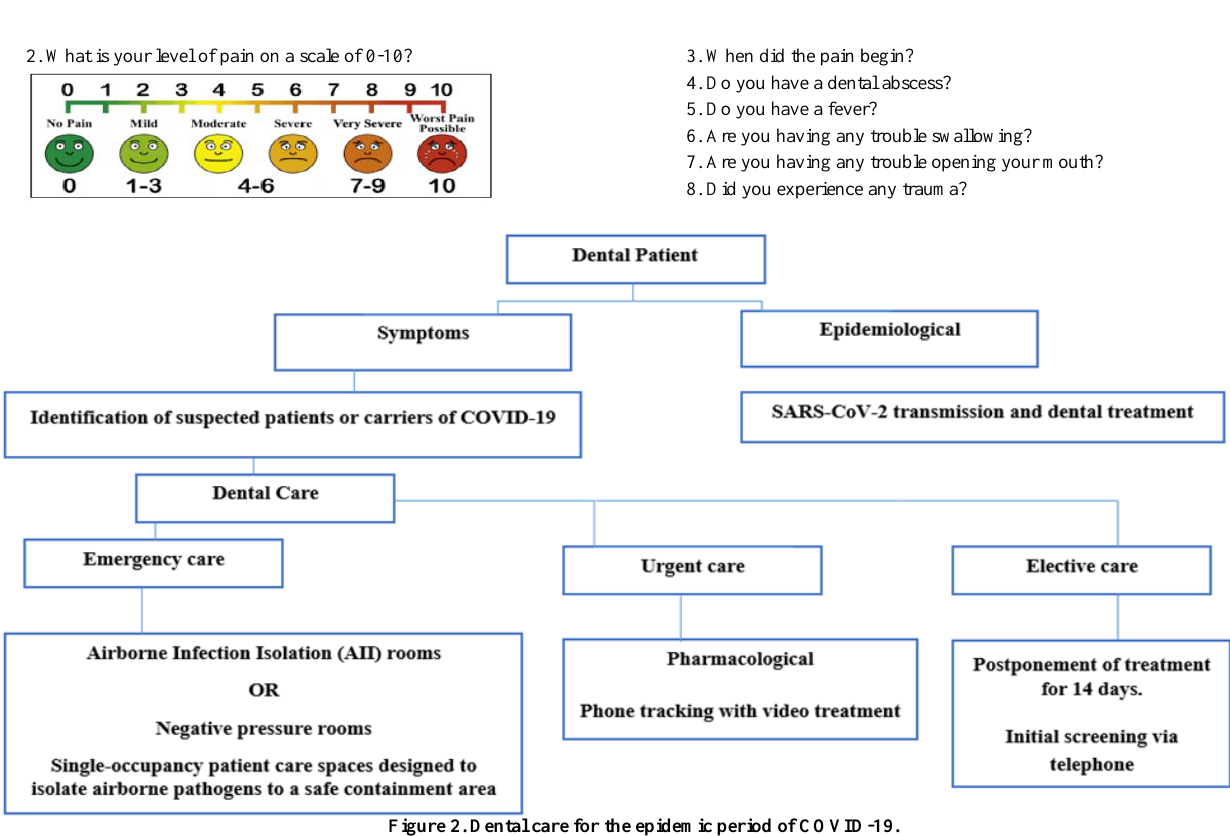
Figure 2. Dental care for the epidemic period of